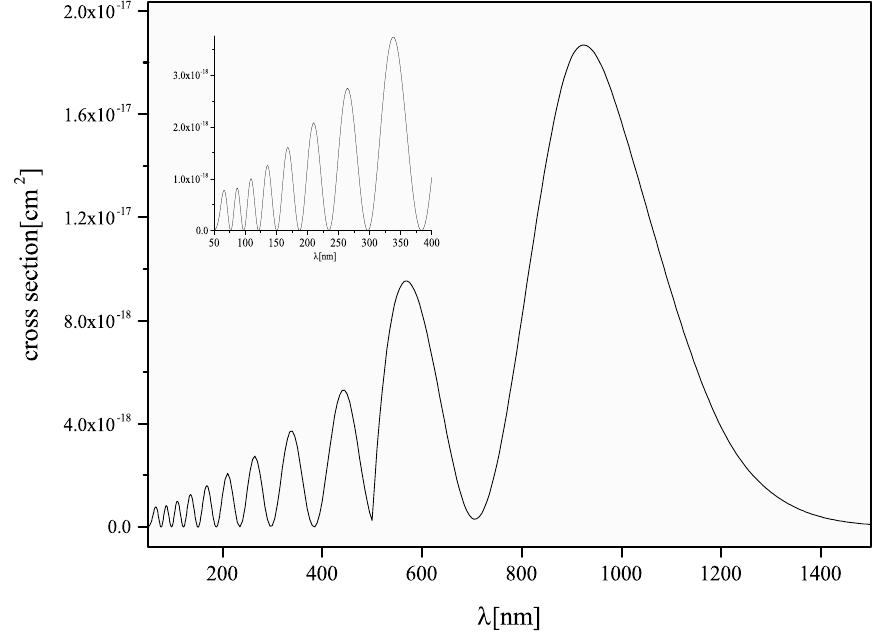
Figure 3. The behaviour of the cross-section σ J , v ( λ ) Equation (3) for J = 0 and v = 10, as a function of λ